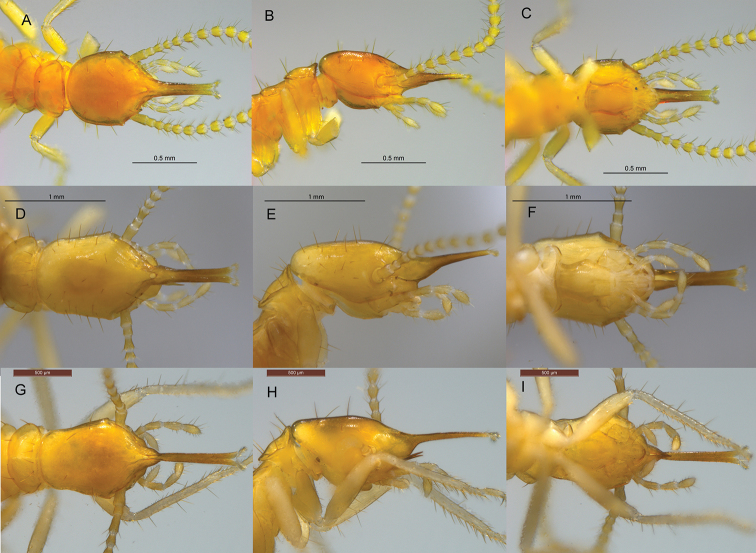
Minor soldiers of Neotropical Rhinotermitinae deposited in UF and CATAC termite collections A–CDolichorhinotermes
longilabiusD–FRhinotermes
hispidusG–IRhinotermes
marginalis.